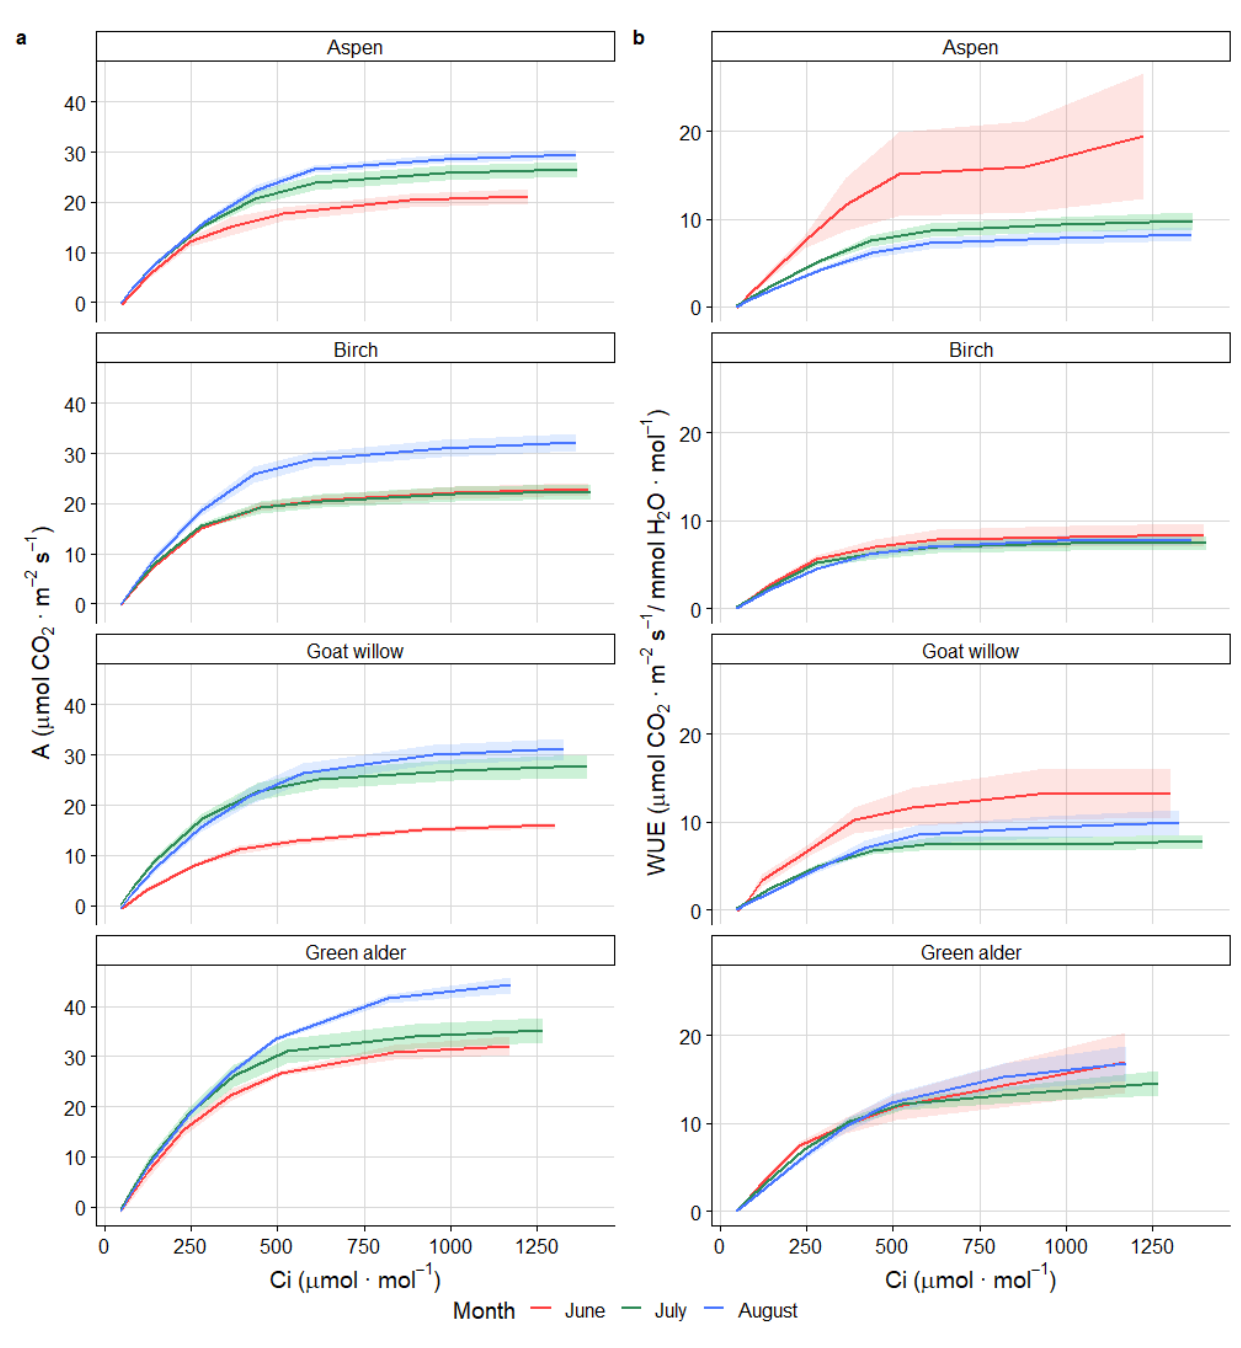
Figure 3. ( a ) Mean response curve of net assimilation relative to intercellular CO 2 concentration as modelled by the FvCB model; ( b ) water use efficiency relative to intercellular CO 2 concentration (shaded areas represent standard error).